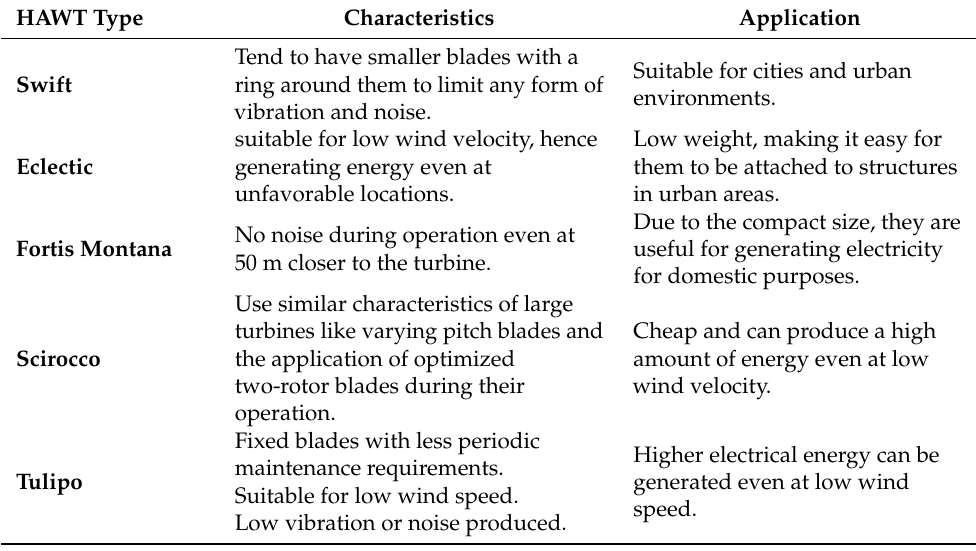
Figure 7. Various orientations of horizontal axis wind turbines: ( a ) Swift type; ( b ) Eclectic type; ( c ) Fortis Montana; ( d ) Scirocco; ( e ) Tulip; ( f - i ) Energy ball; ( f - ii ) Wind wall [74]. Table 1. Types of horizontal axis wind turbines (HAWTs)